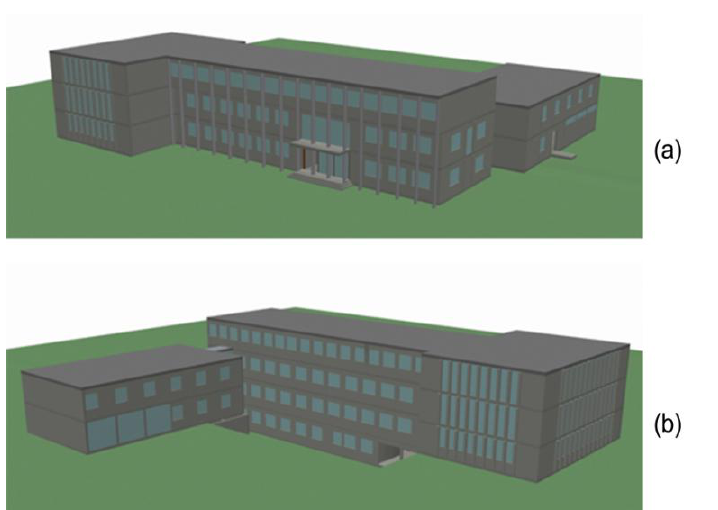
Figure 4. A 3D model of the use case building: the front side with the main entrance ( a ) and the back side with the garage doors and basement windows ( b